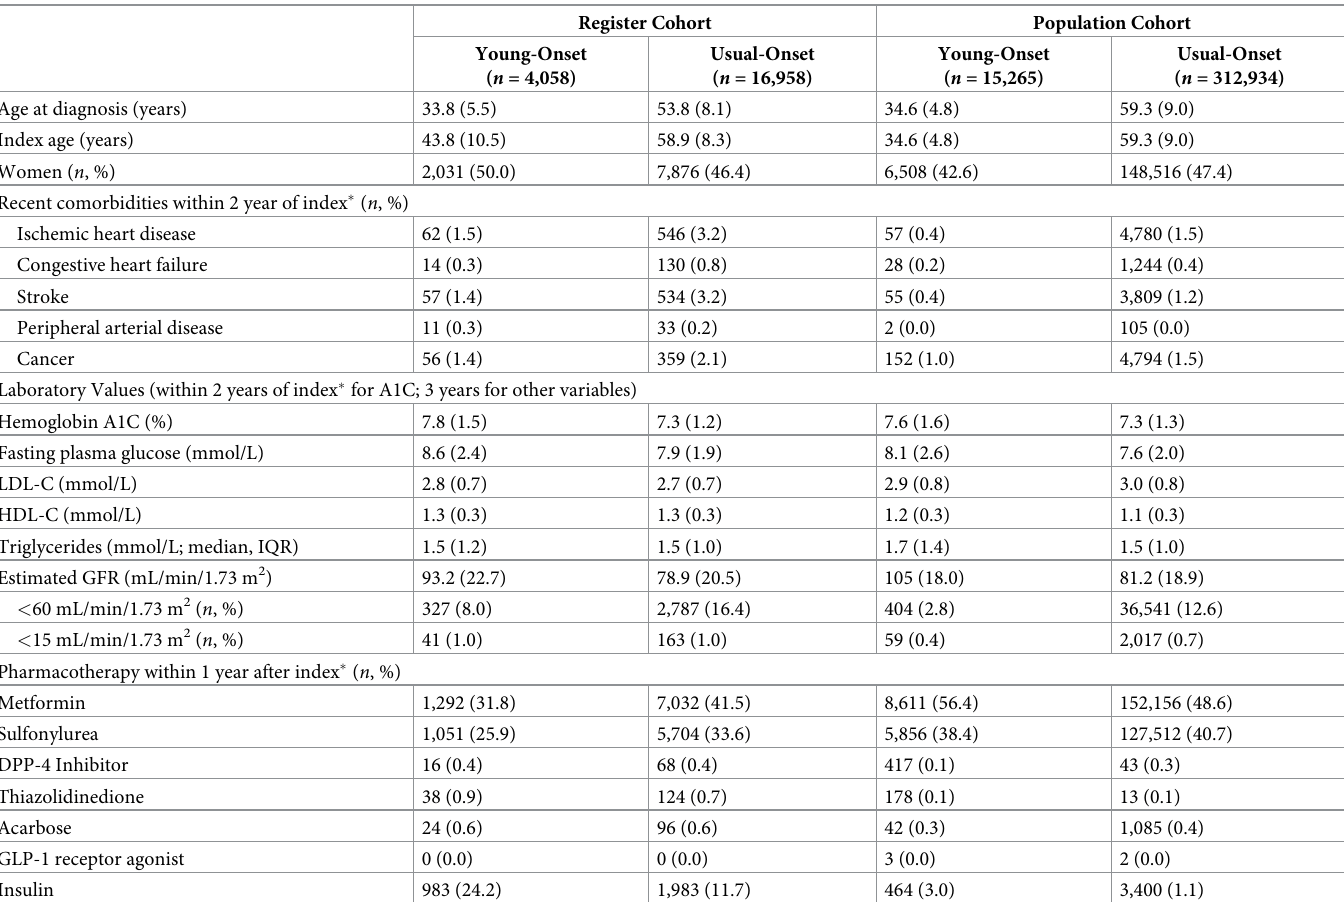
Table 1. Baseline characteristics in the register (2000–2016) and population (2002–2016)